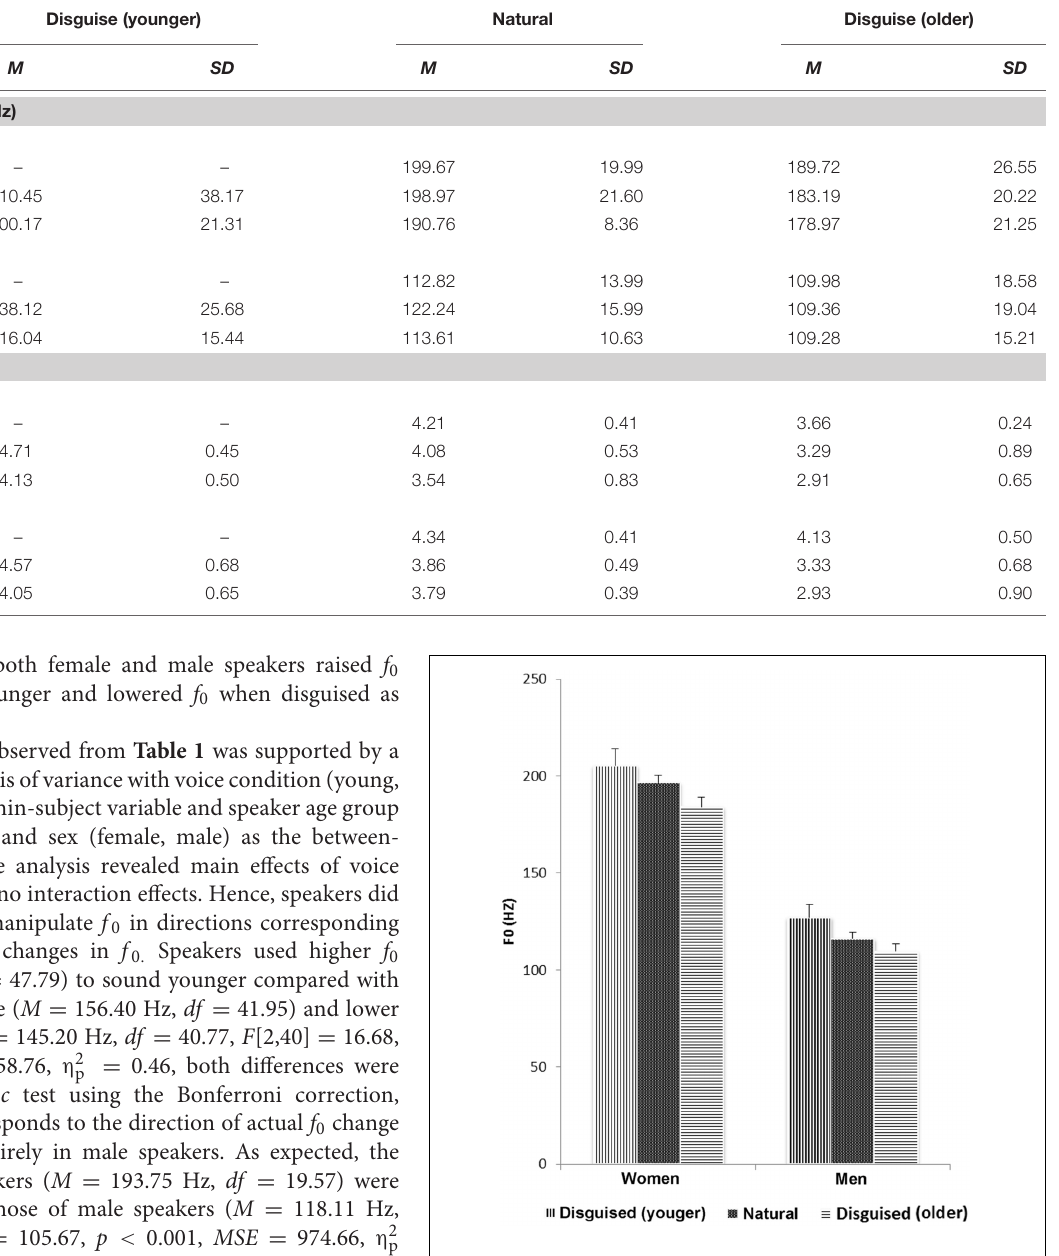
Speech Rate Mean and standard deviation of speech rate for women and men over voice conditions and age groups are shown in Table 1 . Both female and male speakers spoke faster when disguised as younger and slower when disguised as older. This was first confirmed by a 3 × 2 × 2 mixed analysis of variance with voice